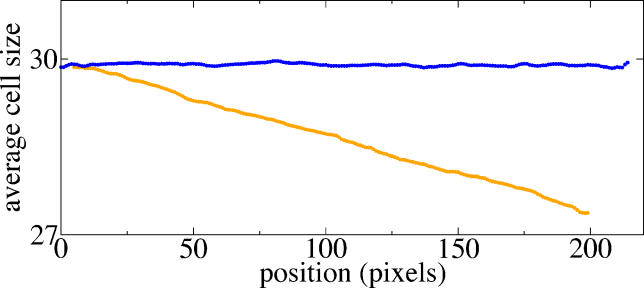
Average Cell Sizes in a Homogeneous Cell Mass Moving Chemotactically to the RightMotion is either unrestricted (blue line), or confined at position 200 (orange line). When motion is confined, a pressure gradient forms that counteracts the chemotaxis. Cell sizes are the average for each column during 50 MCS, sampled after 15000 MCS. Jl,l = Jl,m = 5, μ = 2, no dark cells; other parameters as in Figure 1.